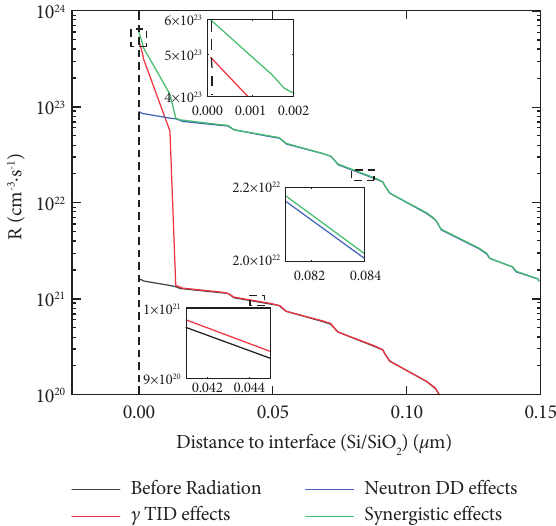
Figure 7: Total carrier recombination rate from the interface to the bulk of silicon.